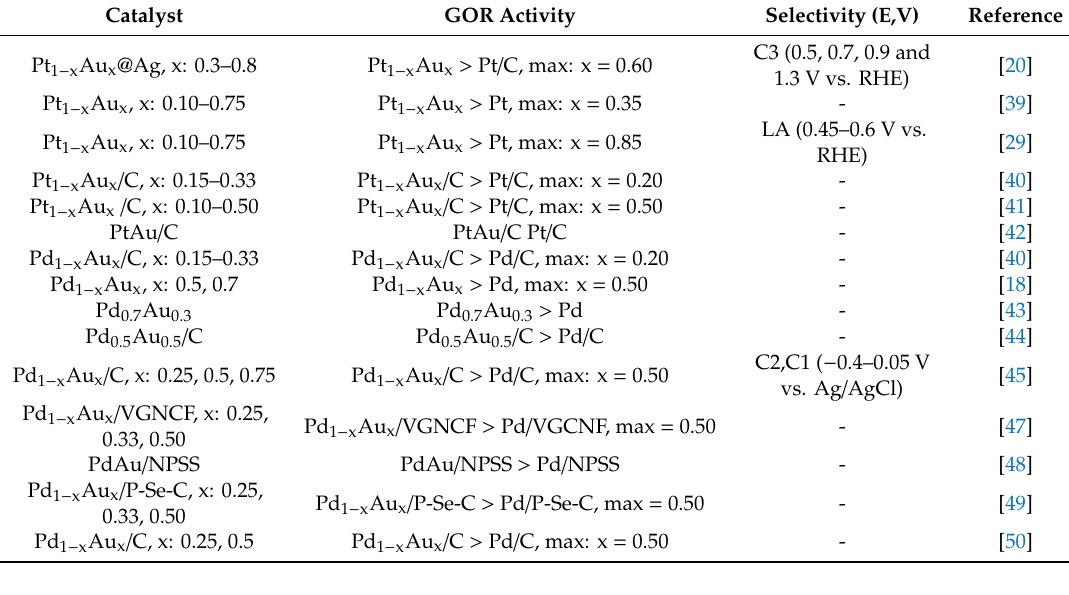
Table 1. Glycerol oxidation reaction (GOR) activity and selectivity in alkaline media of binary PtAu and PdAu catalysts.